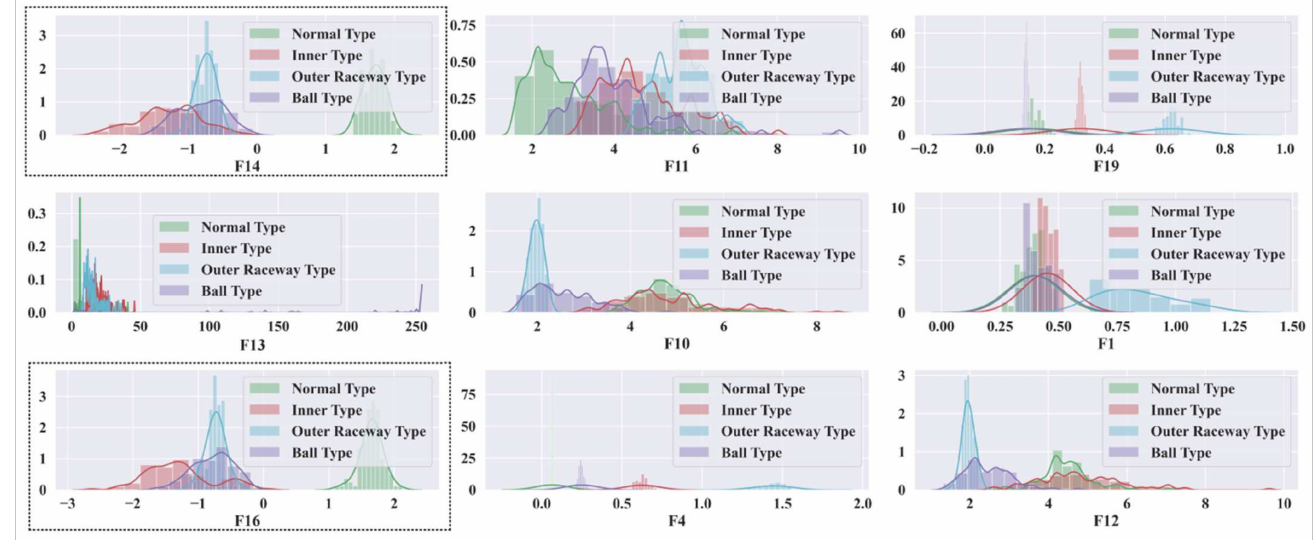
Figure 13. Feature distribution of FFP for model 1 in Table